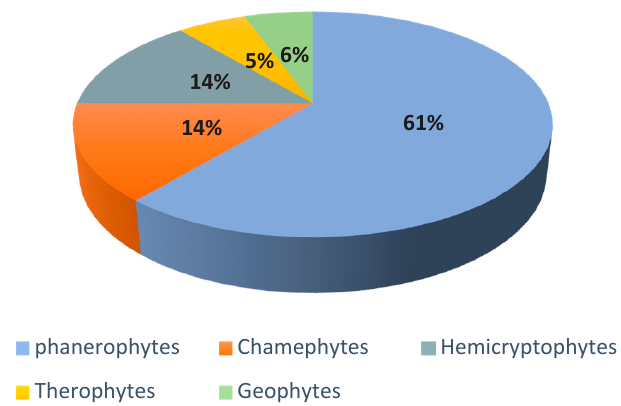
Figure 3. Biological types of plant species encountered in the study area. In the study area, perennials dominate with a percentage of 89%, while annuals and biennials represent only 5% and 6%, respectively (Figure 4).